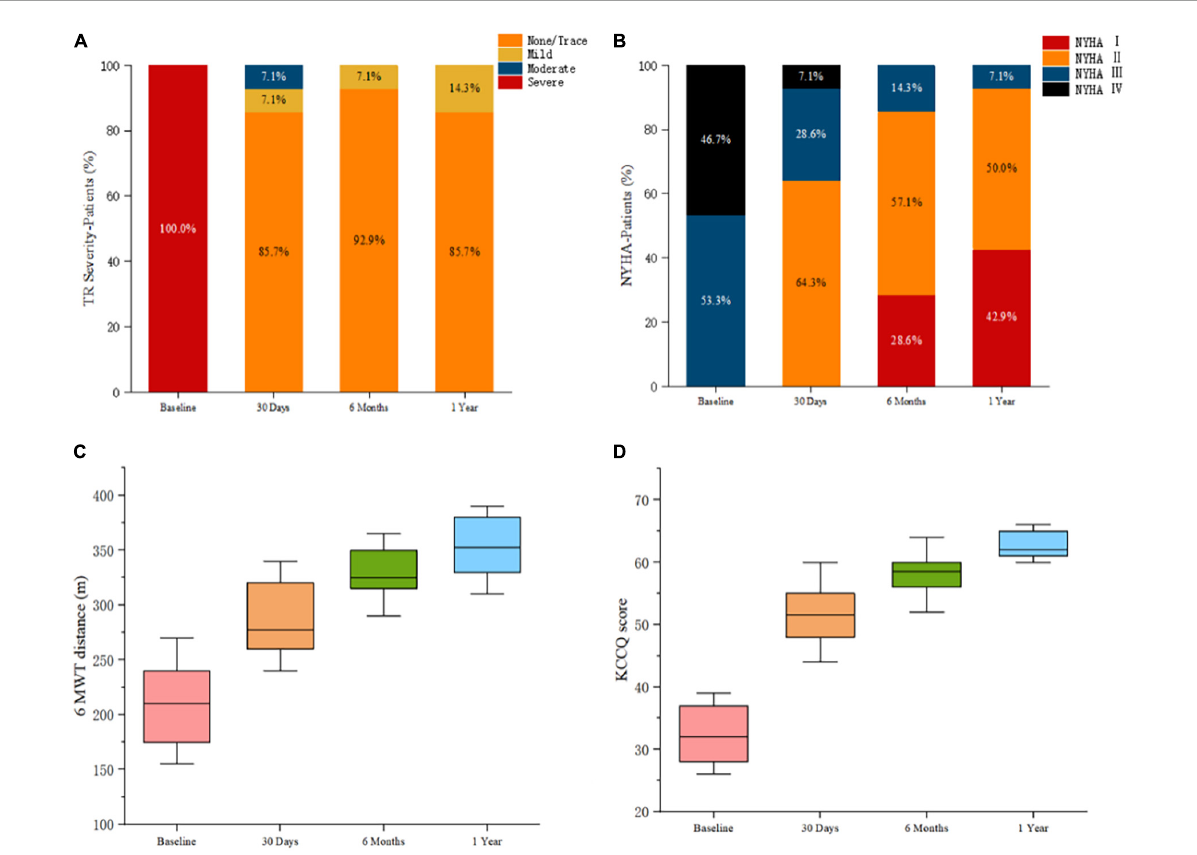
FIGURE5 Postprocedural evaluation showed reduced severity of triscuspid regurgitation and improved clinical, functional, and quality-of-life outcomes. (A) Assessment of severity of tricuspid regurgitation. P -value calculated from the Wilcoxon signed rank test. (B) Comparison of New York Heart Association functional class pre-and post-procedures. P -value calculated from the Wilcoxon signed rank test. (C) Assessment of the 6-min walk test distances. P -value deter-mined from the paired Student t -test. (D) Assessment using the Kansas City Cardiomyopathy Questionnaire. P -value determined from the paired Student t